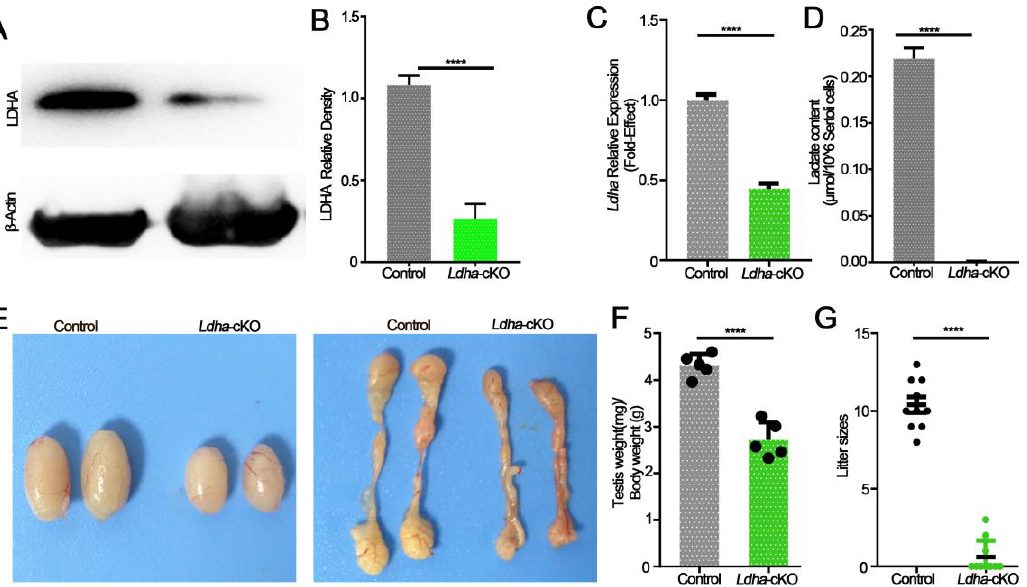
Figure 2. LDHA deficiency in Sertoli cells leads to smaller testes and subfertility. ( A ) Western blot image showing LDHA expression in the control and Ldha -cKO testes. ( B ) Quantitative data of LDHA in three-month-old male control mice and Ldha -cKO mice. (n = 5). ( C ) An analysis of Ldha mRNA expression in the control and Ldha -cKO testes of three-month-old males. ( D ) A comparison of LHDA content in three-month-old male control mice and Ldha -cKO mice. ( E ) Representative images of testes and epididymis from three-month-old male control and Ldha -cKO mice. ( F ) Ratios of testes-to-body of the control and Ldha -cKO mice (n = 5). ( G ) Comparisons of litter size between the control and Ldha -cKO mice (n = 5). All quantitative data are presented as the mean ± s.e.m. for n = 5 independent mouse replicates. **** indicates a significant difference of p < 0.0001. Gray indicated control, and green indicated Ldha -cKO mice.